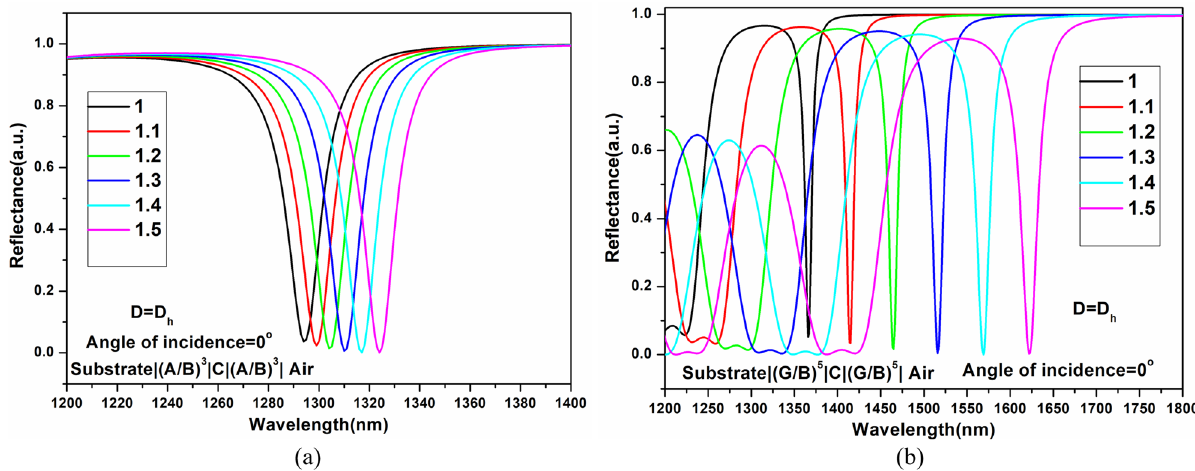
Figure 4. Impact of analyte infiltration in the structure of defect layer thickness D = D h for ( a ) SI-PhCR structure and ( b ) EG-PhCR